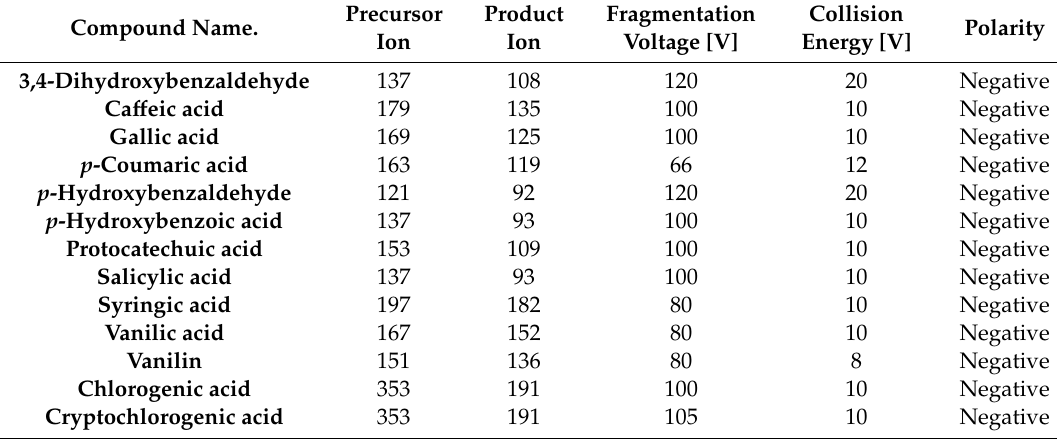
Table 2. Parameters characterizing LC / MS detection for phenolic acids and aldehydes. Compound